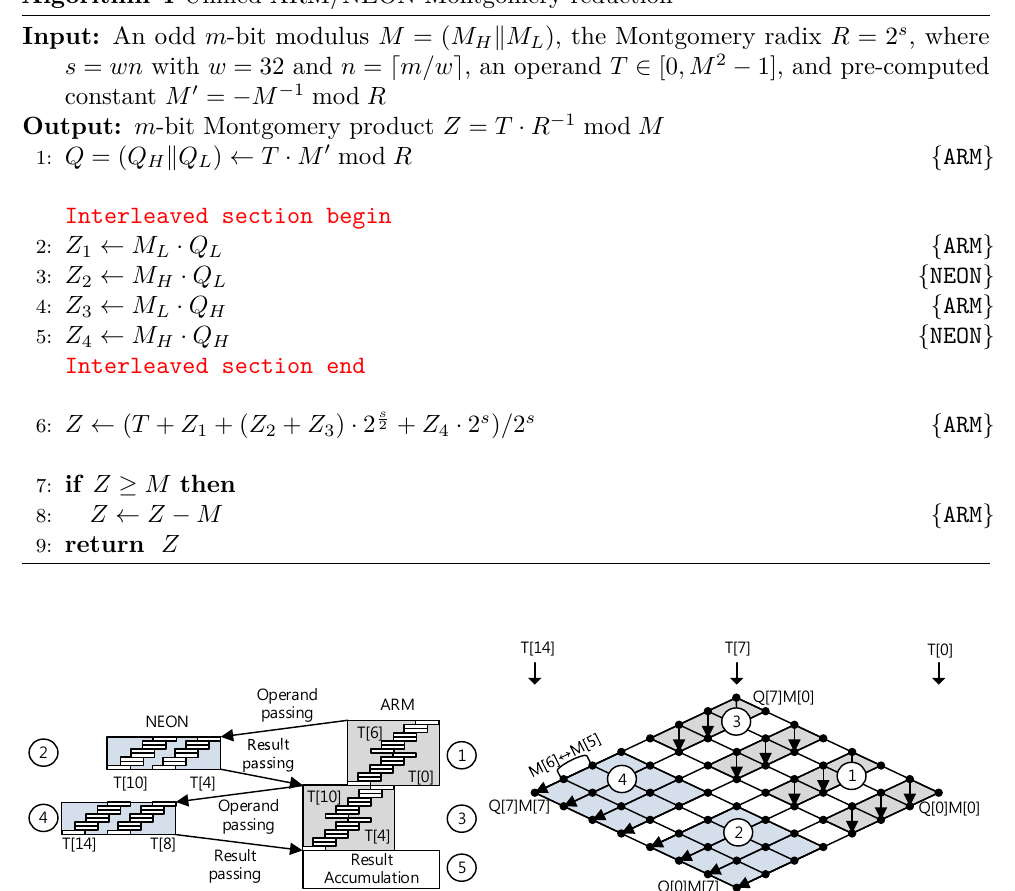
Algorithm 4 Unified ARM/NEON Montgomery reduction